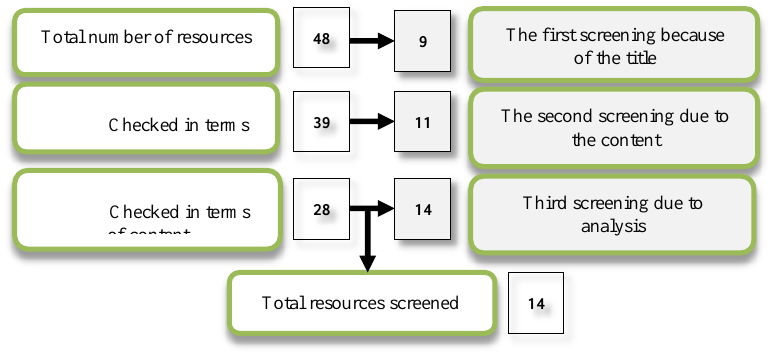
Figure 1. Screening of initial